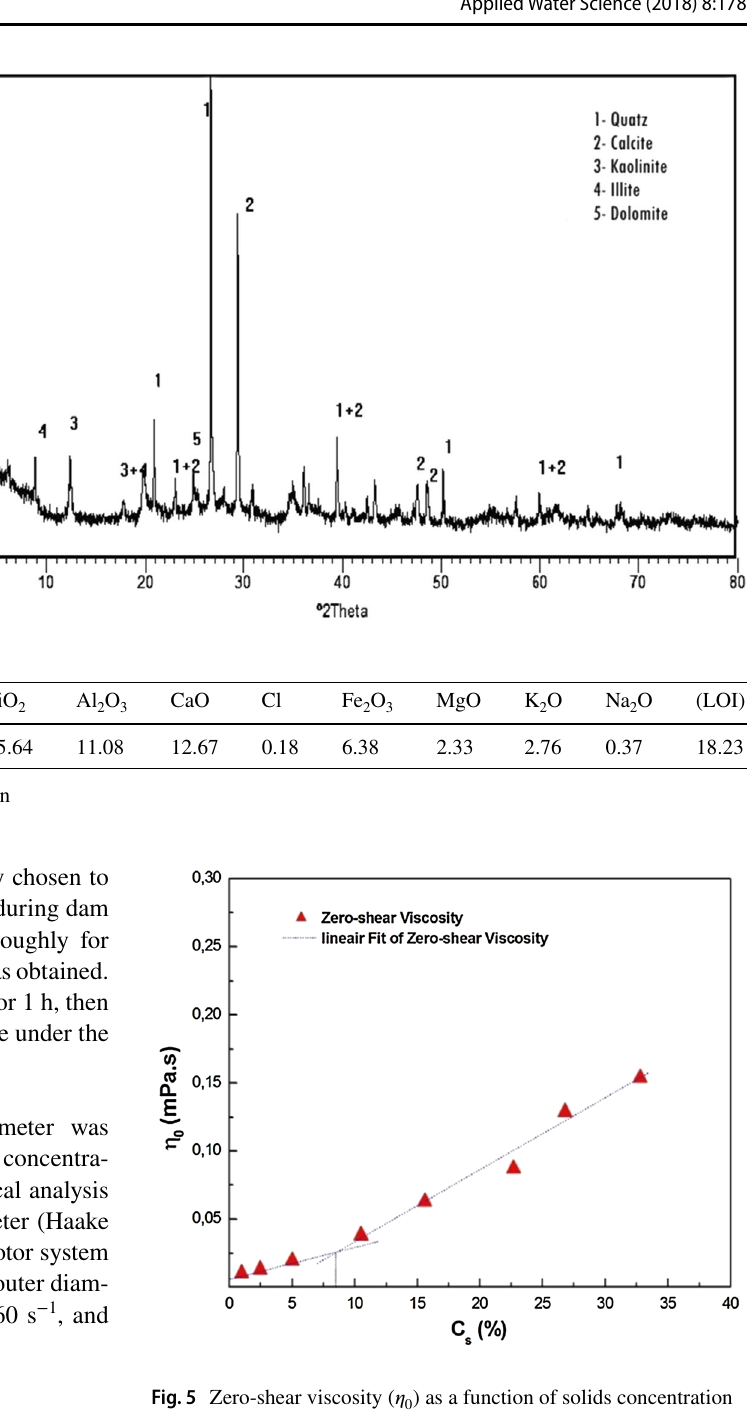
Fig. 5 Zero-shear viscosity ( 𝜂 0 ) as a function of solids